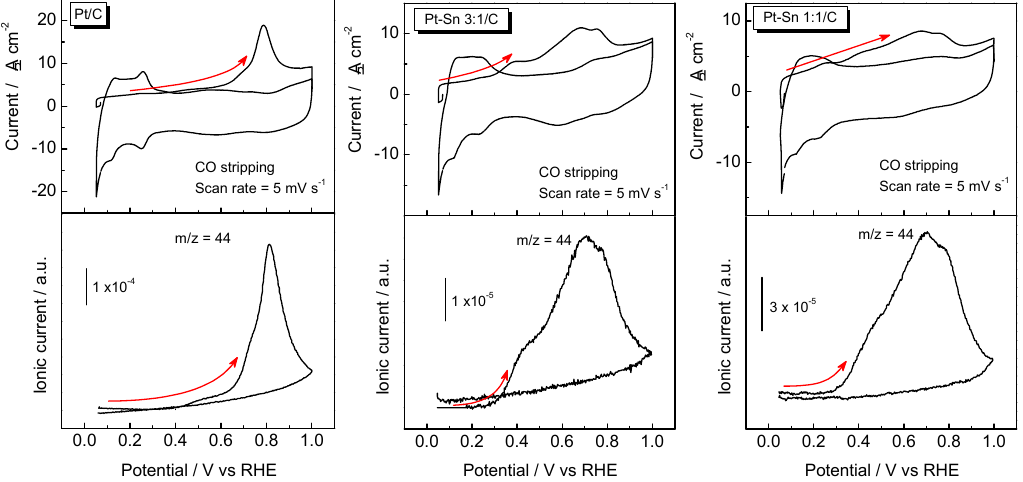
Figure 1. Cyclic voltammograms (CV) and mass spectrometric CV (MSCV) for CO stripping. Faradaic current ( top panel ) and ionic current for m / z = 44 signal ( bottom panel ) registered during a CO ad monolayer electrooxidation on Pt/C, Pt–Sn 3:1/C and Pt–Sn 1:1/C in 0.5 M H 2 SO 4 at room temperature. v = 0.005 V·s − 1 .